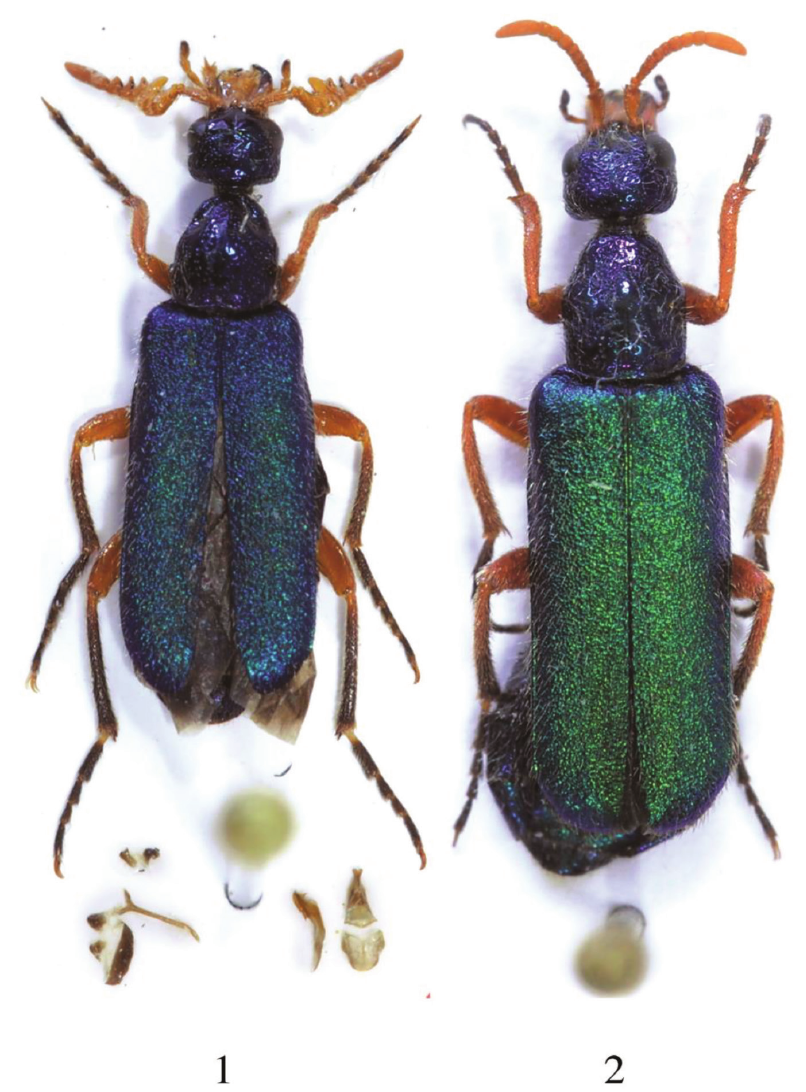
Figure 1–2. Diphorocera neglecta sp. n., 1 holotype male and 2 paratype female. Systematic remarks. Turco and Bologna (2007) established three groups of spe- cies within the genus based on a cladistic analysis: (i) the obscuritarsis group ( carinicol- lis, johnsoni, obscuritarsis ) with the last male antennomere subquadrate and unmodi- fied simple foretibiae; (ii) the promelaena group ( promelaena ) characterised by the last antennomere elongate, male foretibia modified only distally and by black body and pronotum; (iii) the hemprichi group ( chrysoprasis , hemprichi , sicardi , peyerimhoffi ) with the last antennomere elongate and foretibiae